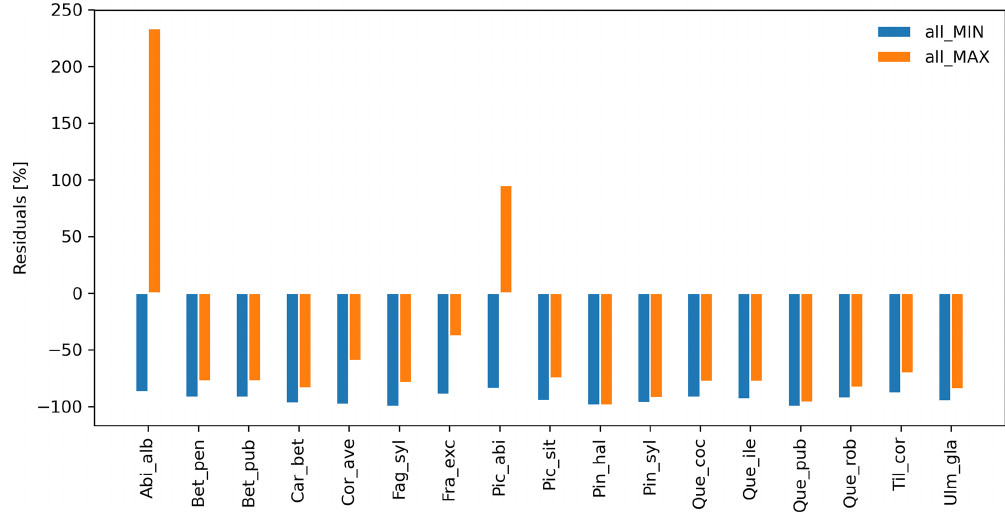
Figure 2. Species-level residuals of observed versus predicted migration rates for extreme parameter settings. The observed migration rates refer to the maximum value of historical estimates (upper boundaries of migration rates in Table 1; Eq. 5). all_MIN: all migration parameters are fixed to their minimum values; all_MAX: all migration parameters are fixed to their maximum values. See Table B2 for species-specific extreme parameter values, and Table S2 for species-specific